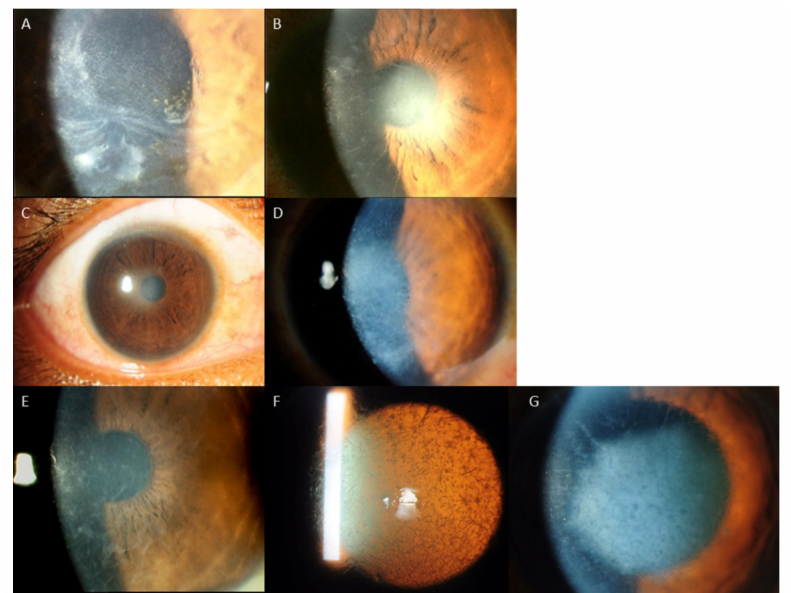
Figure 2. Different phenotypes of LCD1 associated with the same R124C mutation: ( A ): subepithelial haze and feathery opacities; ( B ): Thin lattice lines with subepithelial haze; ( C ): Central subepithelial haze only; ( D ): Central subepithelial haze with white dots and few lattice lines; ( E ): Dots and fleck like deposits; ( F , G ): Lattice lines with multiple grayish white dots and some spiky deposits (GCD2).